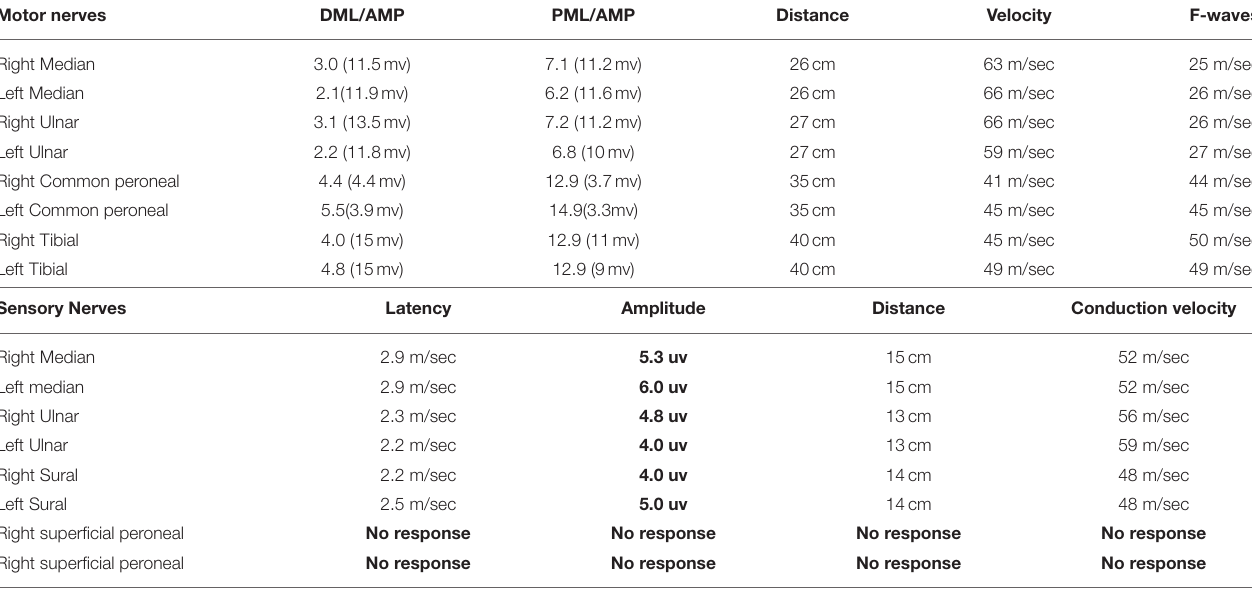
TABLE 1 | Showing Nerve conductive studies of tested nerves with the interpretation of results and final conclusion (abnormal parameters are shown in bold). Motor nerves